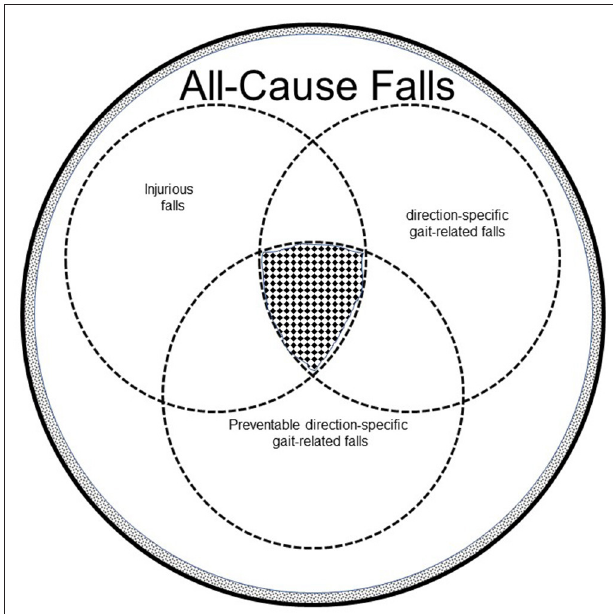
FIGURE 1 | The total encircled area represents all-cause falls by all older adults. The white area represents all-cause falls by independent community dwelling older adults, who represent 95% of older adults in the United States (Administration on Aging, 2012, http://www.aoa.gov/Aging_Statistics/Profile/ 2012/docs/2012profile.pdf). The dotted area represents all-cause falls by older adults living in assisted living facilities. Direction-specific gait-related falls are a subset of all-cause falls. Slips and trips, direction-specific falls, that occur both in and outside the home, may generally account for about 50% gait-related falls by independent community-dwelling older adults ( Berg et al., 1997; Crenshaw et al., 2017 ). A substantial number of falls by independent community-dwelling older adults are laterally-directed (Crenshaw et al., 2017). Because laterally-directed falls may have recovery solutions that involve stepping responses, the percentage of preventable direction-specific gait-related falls is increased. Of these gait-related falls, some proportion leads to injury, both minor and serious, the latter of which can be life-threatening. Of these direction-specific gait-related falls by independent community-dwelling older adults, some are demonstrably preventable through various clinical interventions. The hatched area at the intersection of injurious falls, direction-specific gait-related falls. and preventable, direction-specific gait-related falls represents out target for perturbation-based